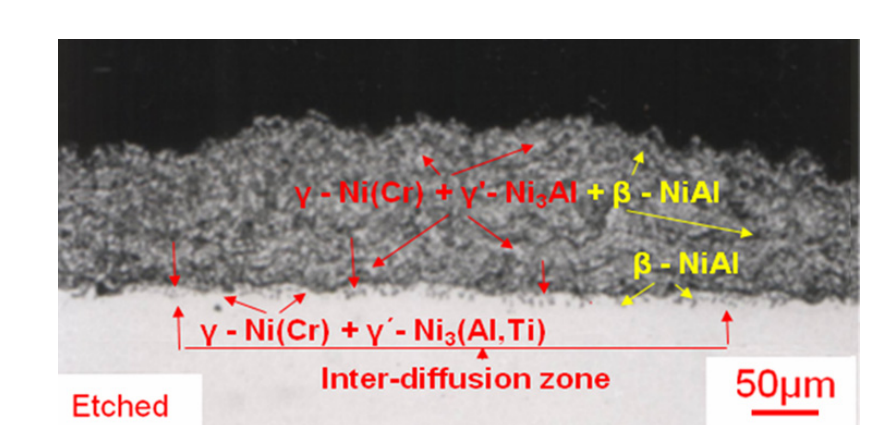
Figure 5 – (OM) Etched microstructure of the Ni22Cr10Al1Y coating after heat treatment at 1100 º C/2 hours Рис . 5 – ( ОМ ) Поврежденная микроструктура покрытия